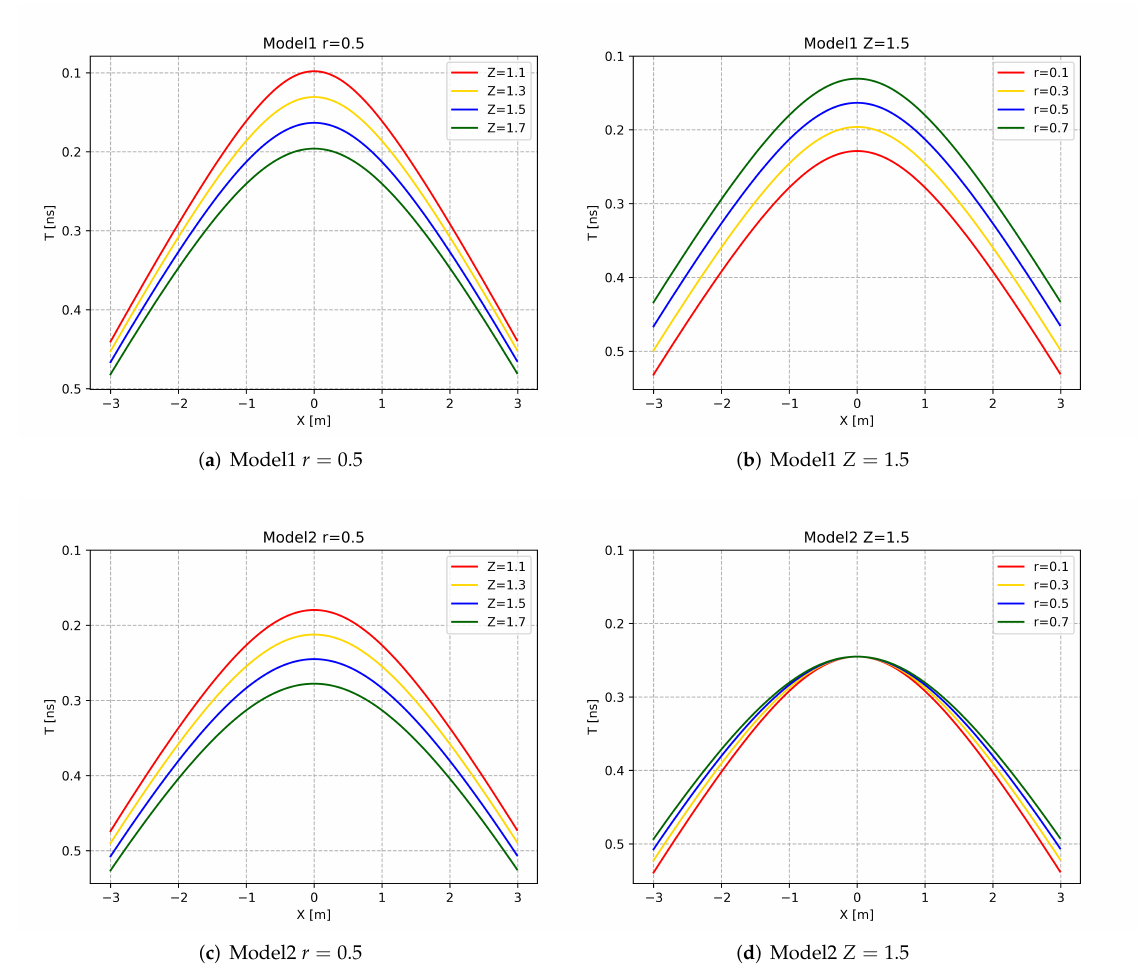
Figure 7. The way parameters affect the shape of the hyperbola in different physical